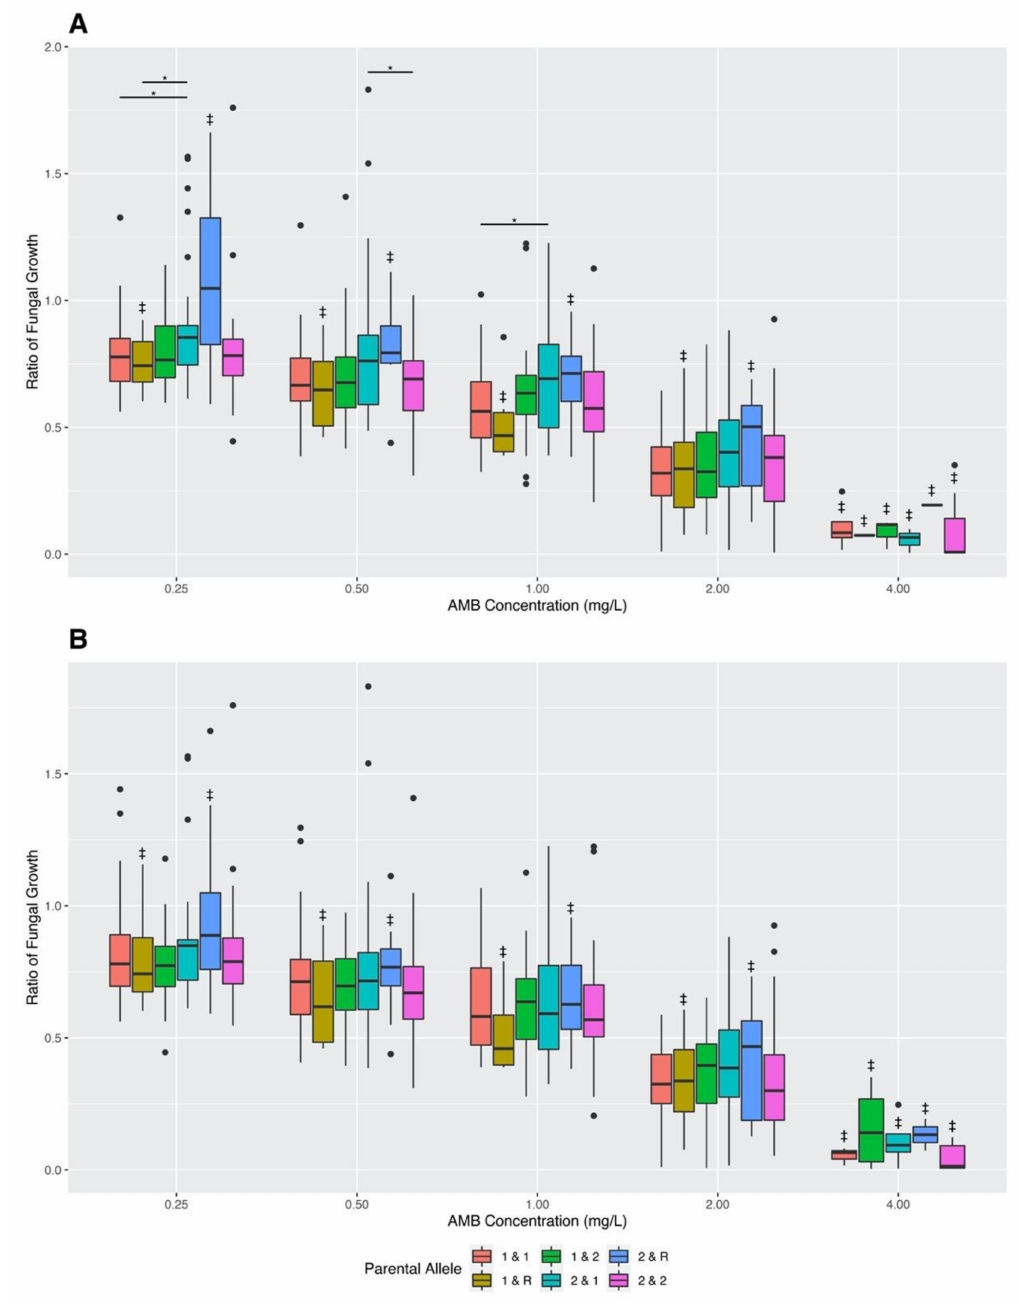
Figure 5. Growths of the 143 progeny strains in varying Amphotericin B concentrations, grouped based on the variant genotype combination at the sites ( A ) SNP 5 and Group A and ( B ) SNP 1 and Group A. Fungal growth was determined by calculating difference in OD 530 at start (0 h) and end of incubation (48 h); this value was divided by fungal growth in the positive control to determine ratio of fungal growth. Parental allele 1 denotes the AFB62-1 genotype, parental allele 2 denotes the CM11 genotype, and R denotes recombination in the SNP group. “*” denotes statistically significant differences (Welch’s t -test p -values < 0.05) and “ ‡ ” indicates bar groups with n ≤